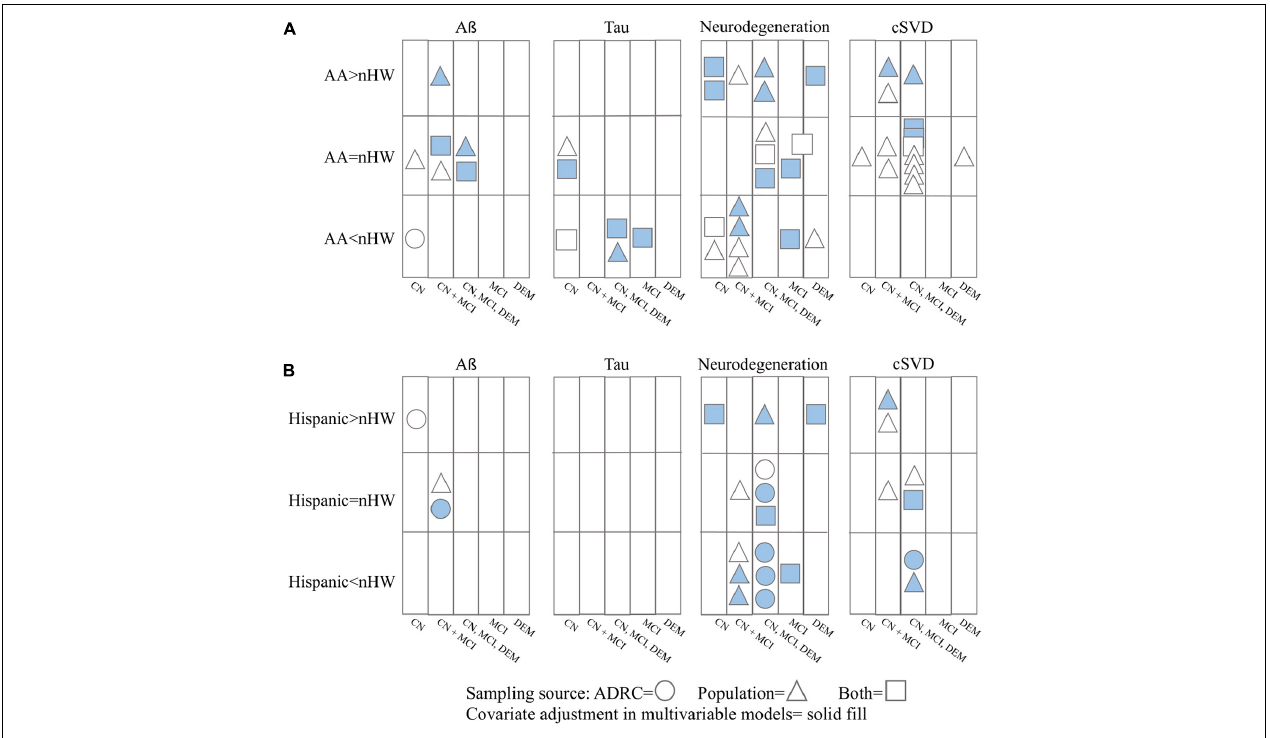
FIGURE 2 | Summary of results for ADRD pathology differences between nHW and (A) African Americans and (B) Hispanics. CN = cognitively normal; MCI = mild cognitive impairment; DEM = dementia. Studies that did not report cognitive status or recruitment source of their participants are not included ( n =